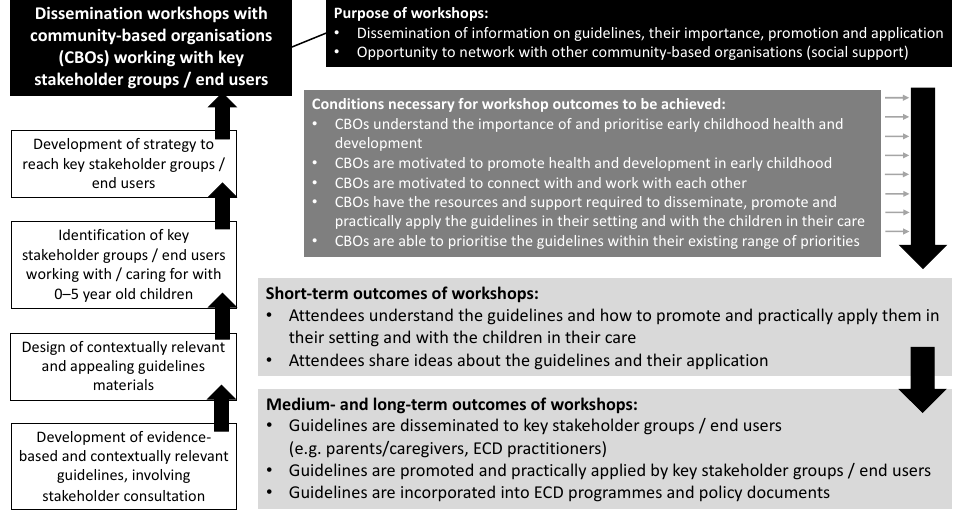
Figure 3. Guideline dissemination programme theory. ECD, early childhood development.